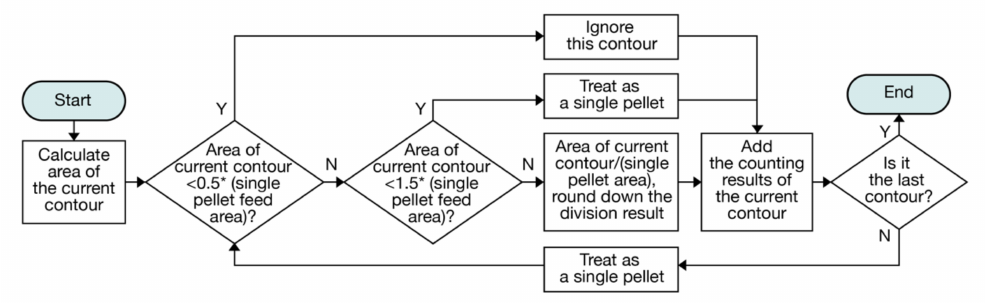
fish to manage the residual feed in aquaculture. A current contour is a single pellet. Based on current contour area, they counted exactly the number of pellets in a heap. Figure 27 shows the flow chart of the counting strategy. Also, Figure 28 shows the underwater images and aquaculture site [98].